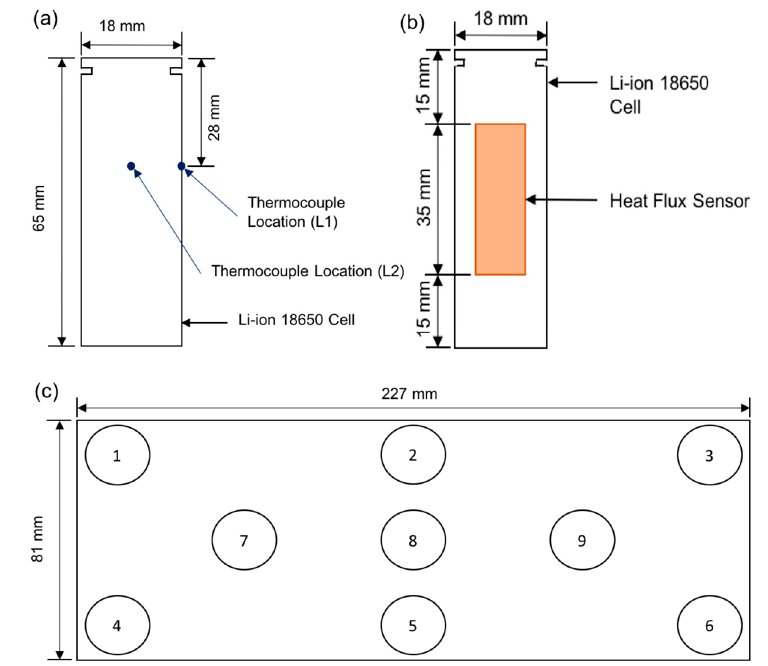
Figure 5. ( a ) Thermocouple placement locations at the leeward side of the battery; ( b ) front view of heat flux sensor placement location; and ( c ) front view of velocity measurement locations at the inlet.